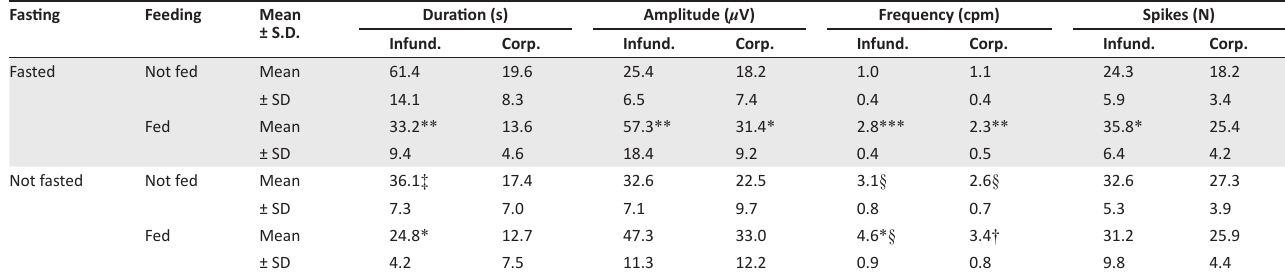
TABLE 2: Characteristics of the long spike burst pattern recorded in the gallbladder infundibulum and corpus in various feeding conditions. Fasting Feeding Mean ± S.D.